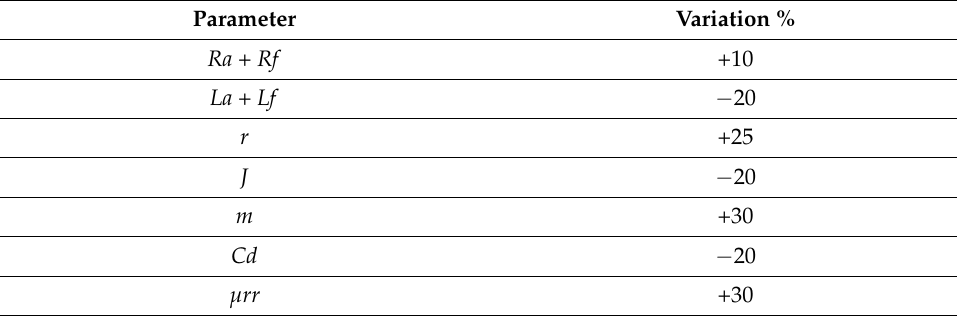
Figure 3. SIMULINK diagram of a nonlinear EV model. Table 2. Uncertainty parameters of an EV system.